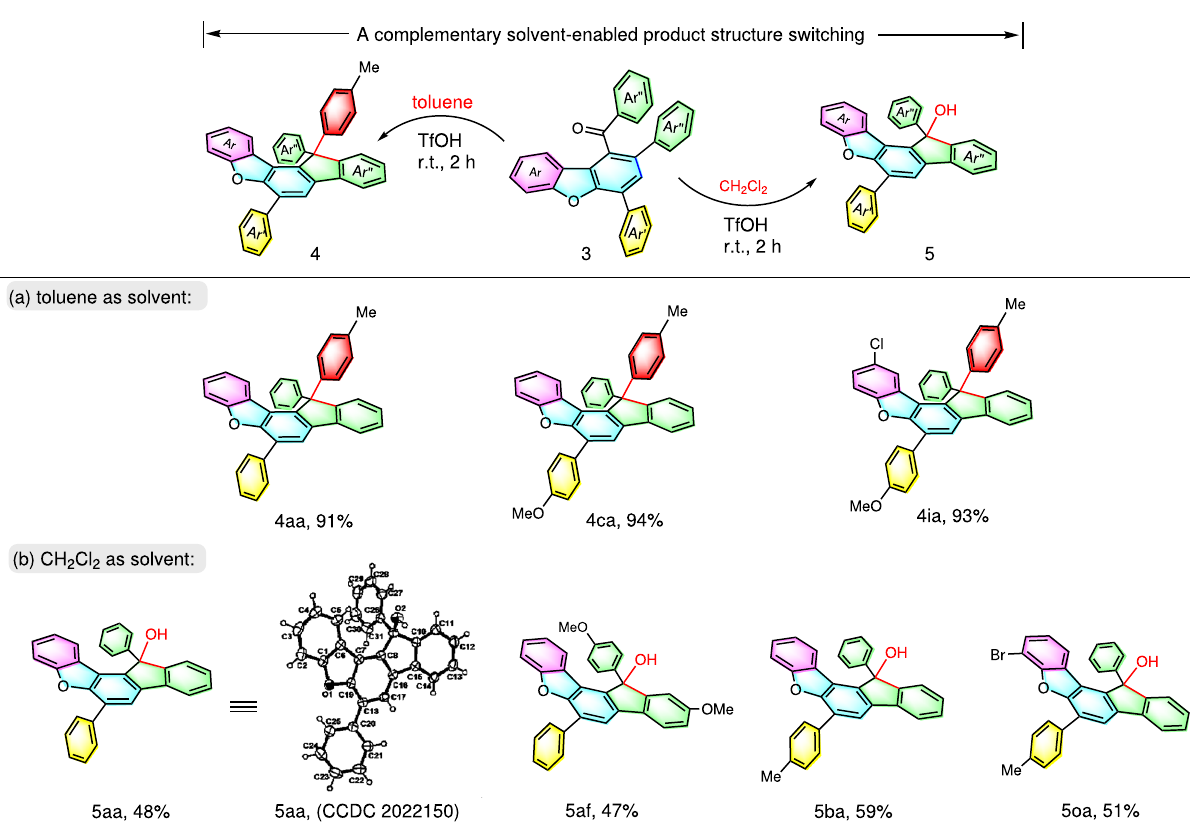
Fig. 6 Possible late-stage elaborations dibenzofuran 3. Reaction conditions: dibenzofurans 3 (0.2 mmol), TfOH (0.6 mmol) were stirred in toluene (2 mL, synthesis of compound 4 for 1 h) or in DCM (2 mL, synthesis of compound 5 for 2 h) at room temperature. Isolated yields were